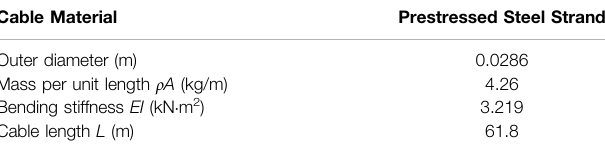
TABLE 6 | Cable parameters in experimental veri fi cation.